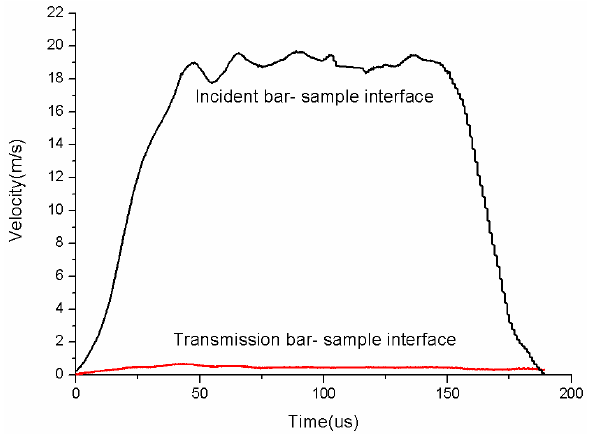
Figure 5. Velocity profiles of the incident bar–specimen interface and transmission bar–specimen interface.